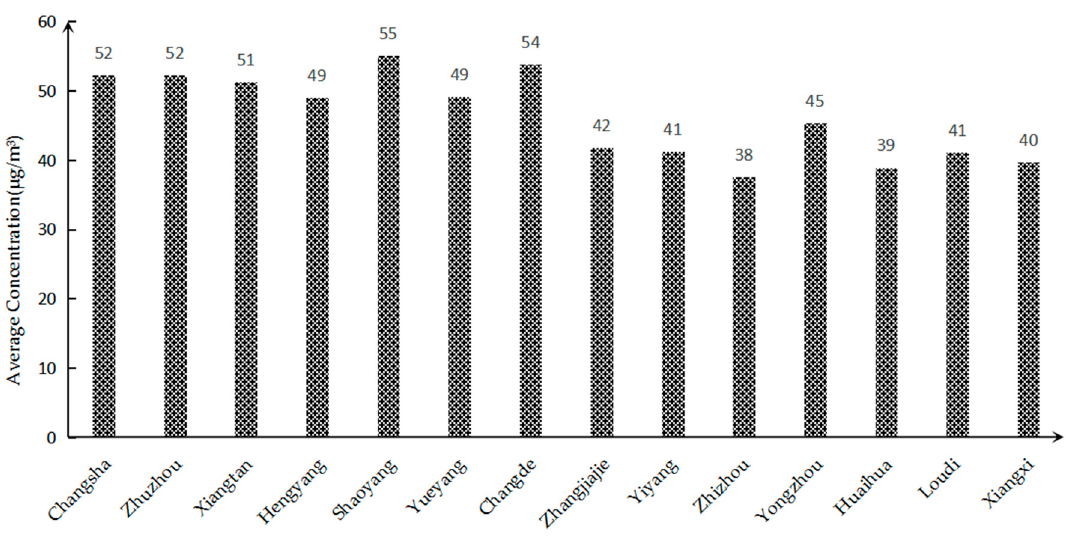
Figure 6. Comparison of PM 2.5 Concentrations in Cities of Hunan Province in 2017.